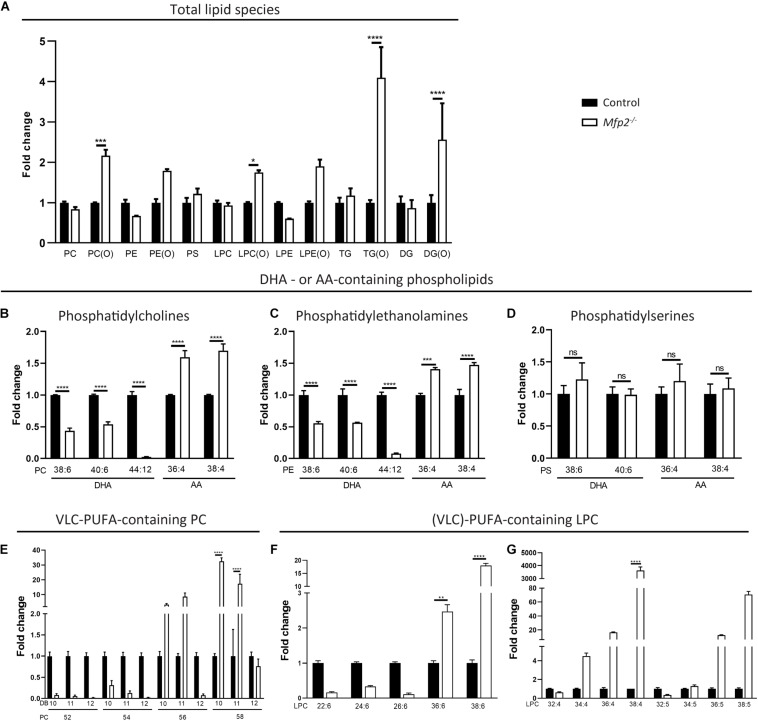
Altered PUFA profile in 3 weeks-old Mfp2–/– retinas. (A) Evaluation of the different lipid classes reveals a general increase in ether lipid species. Lipidome analysis reveals a severe decrease in DHA- and an increase in AA-containing (B) PC and (C) PE phospholipids, but not in (D) PS phospholipids. (E)
Mfp2–/– retinas display a peculiar profile of PC phospholipids containing VLC-PUFAs. PC species with 52–58 carbons and 10–12 double bonds (DB) are shown. Profile of LPC species containing PUFAs with (F) 6 and (G) 4–5 double bonds. Mean ± SEM are shown (n = 3 per genotype). Statistical significance was determined by two-way ANOVA with Bonferroni multiple comparisons test: ns p > 0.05, **p < 0.01, ***p < 0.001, ****p < 0.0001. PC, phosphatidylcholines; PE, phosphatidylethanolamines; PS, phosphatidylserines; TG, triglycerides; DG, diacylglycerides; LPC/LPE, lyso-variant of PC/PE; x(O), ether-variant of the respective lipid species.